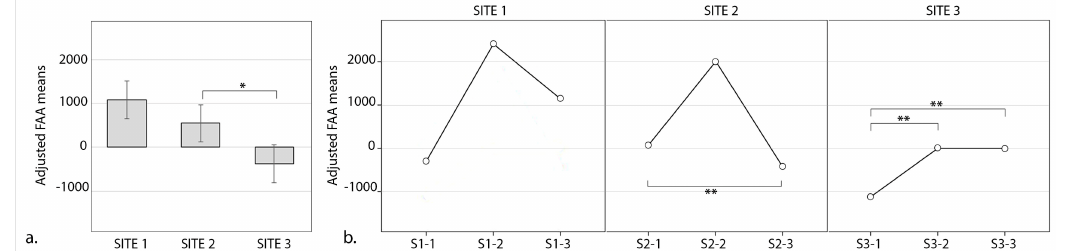
Figure 3. Di ff erences in mean values of frontal alpha asymmetry (FAA) across participants passively viewing the landscapes: ( a ) within 3 sites (Site 1—Urban Park, Site 2—Residential Green and Site 3—Control (Busy Downtown) and ( b ) exposed to nine di ff erent scenes of these sites (S1_1, S1_2, S1_3, S2_1, S2_2, S2_3, S3_1, S3_2 and S3_3; * p < 0.05; ** p <